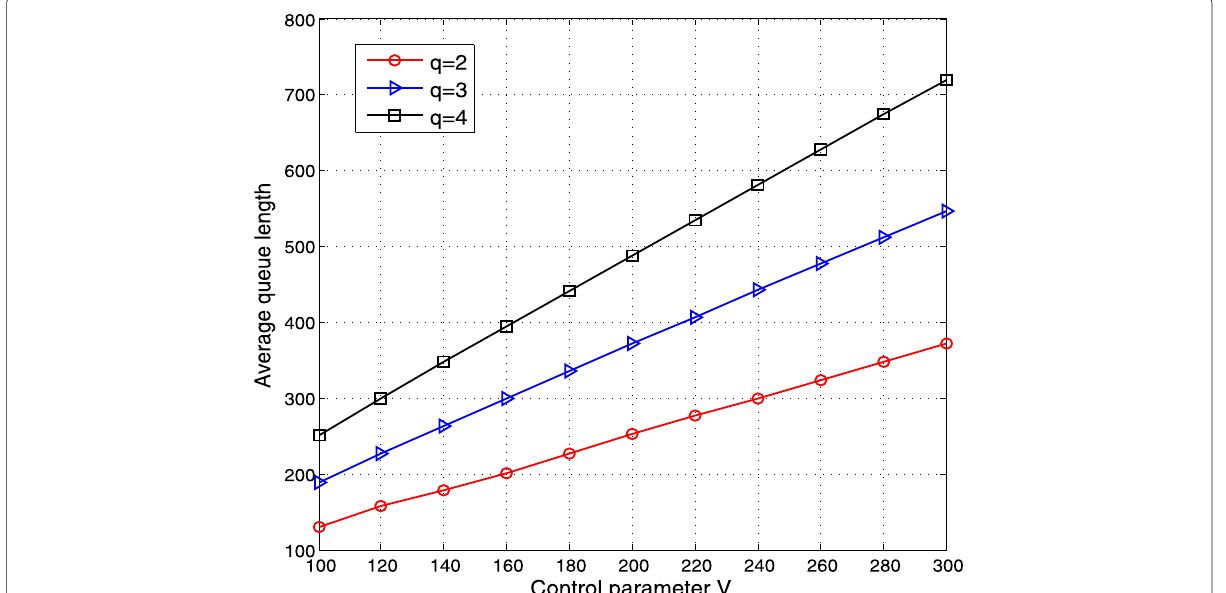
Fig. 8 The average queue length versus the control parameter V with different